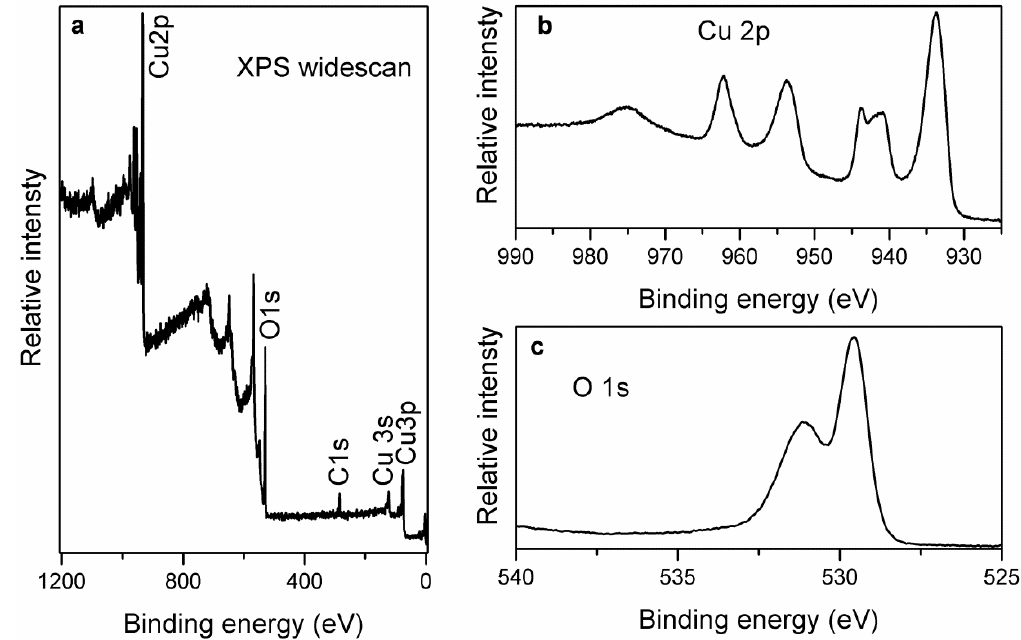
Figure 3. The XPS study of CuO